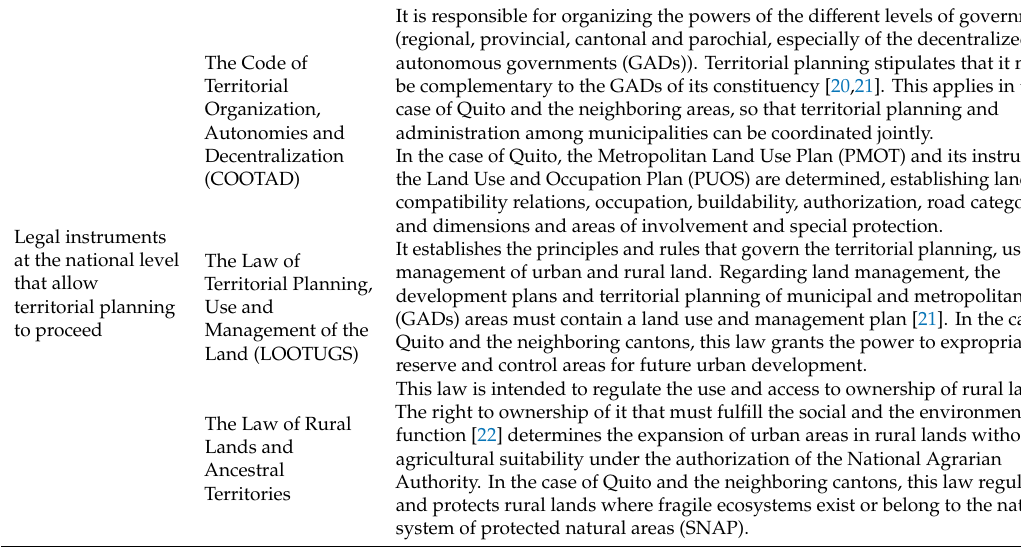
Table 1. Urban planning